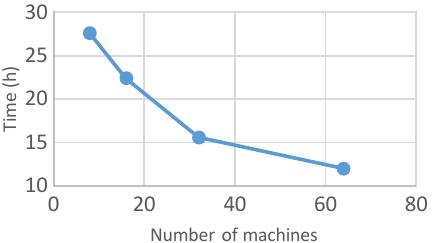
Fig. 17 Average construction time of BDHDLS for 5 (cid:2) 2 CV F test in the ISCX2012